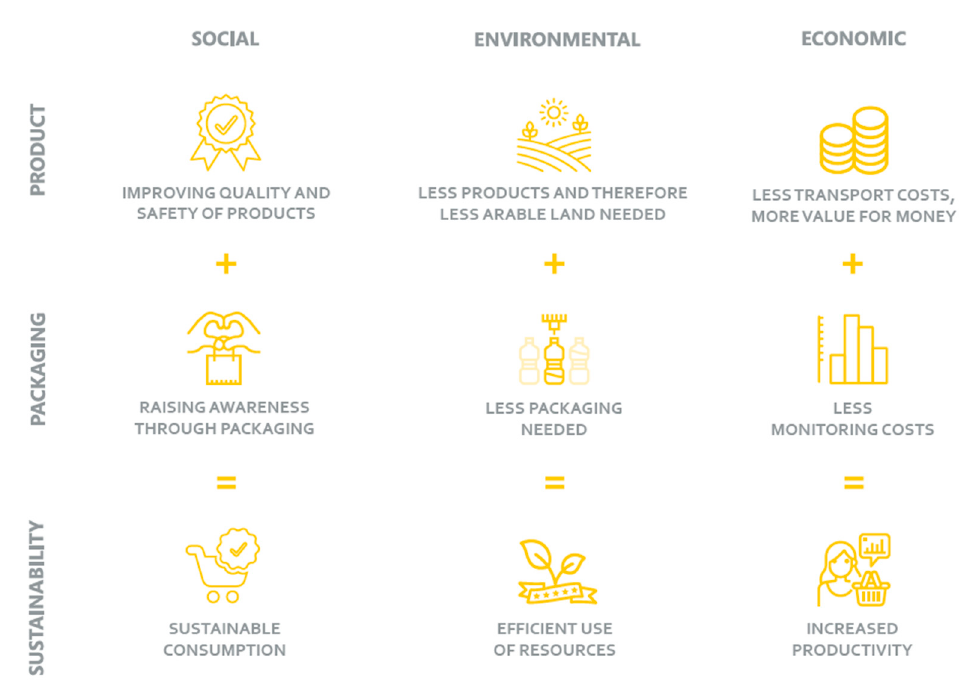
Figure 5. Summary of social, environmental, and economic impacts on sustainability (source, AIP in relation to sustainable development [38]).